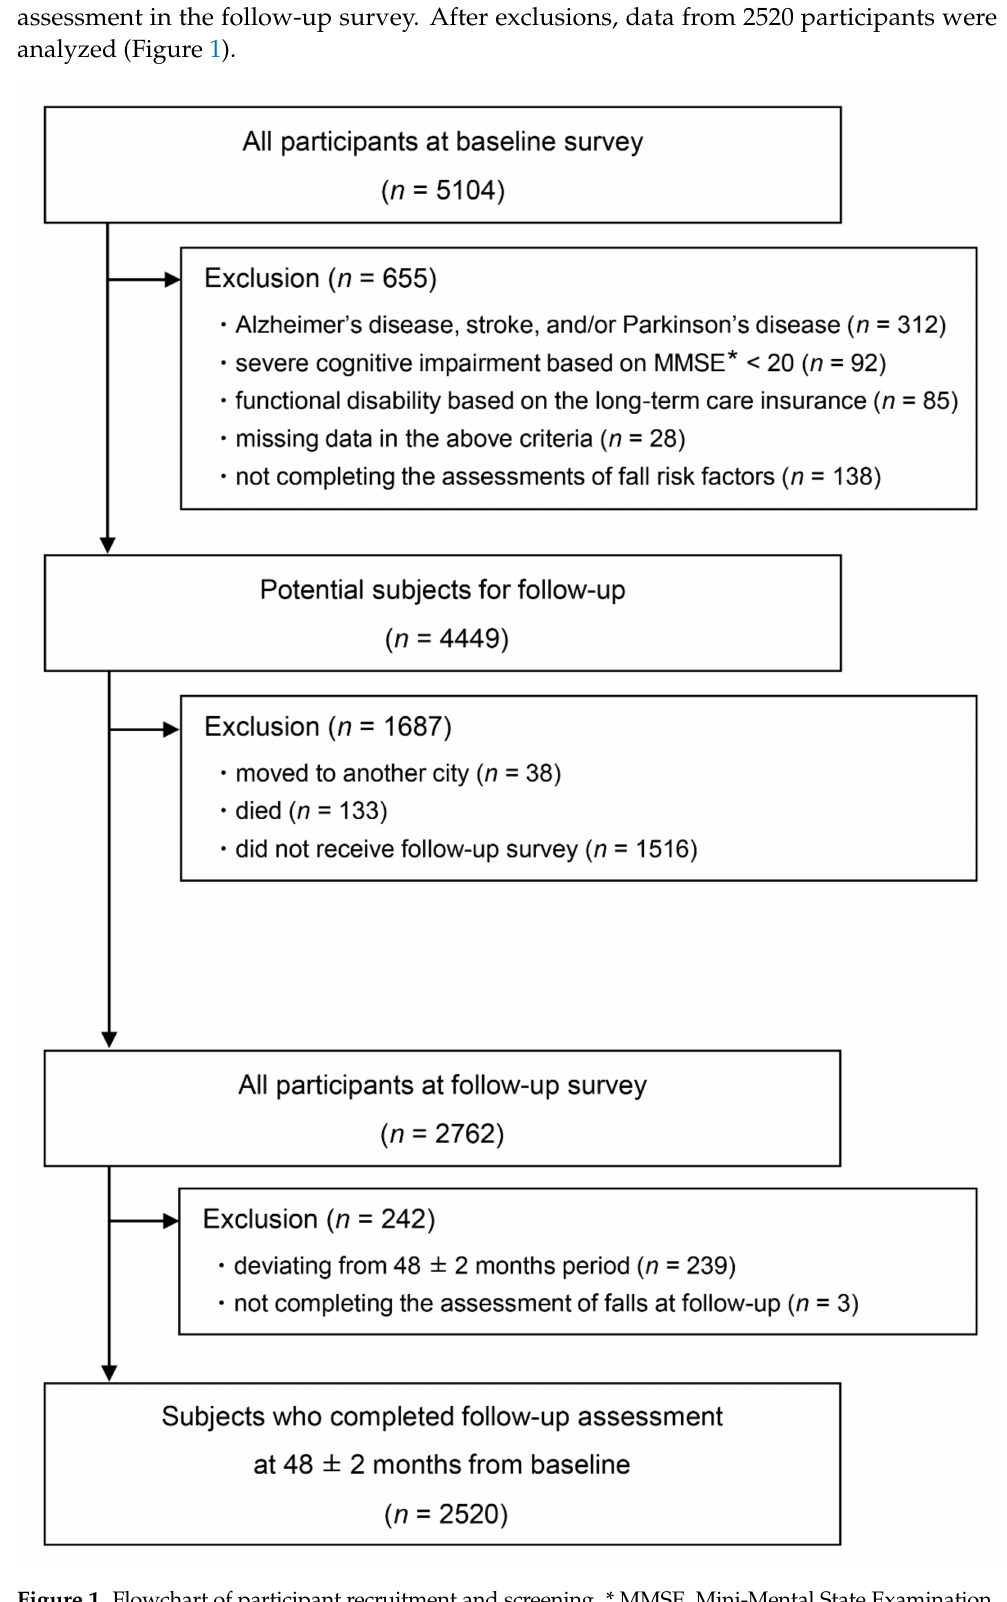
Figure 1. Flowchart of participant recruitment and screening. * MMSE, Mini-Mental State